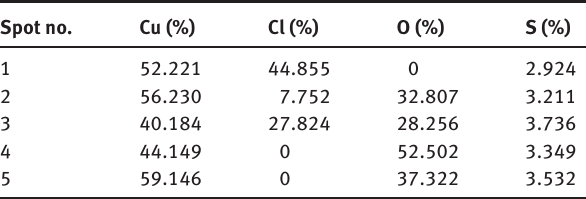
Table 3: The EDS analysis results of different regions of samples in Fig. 10 (atom ratio) Spot no.